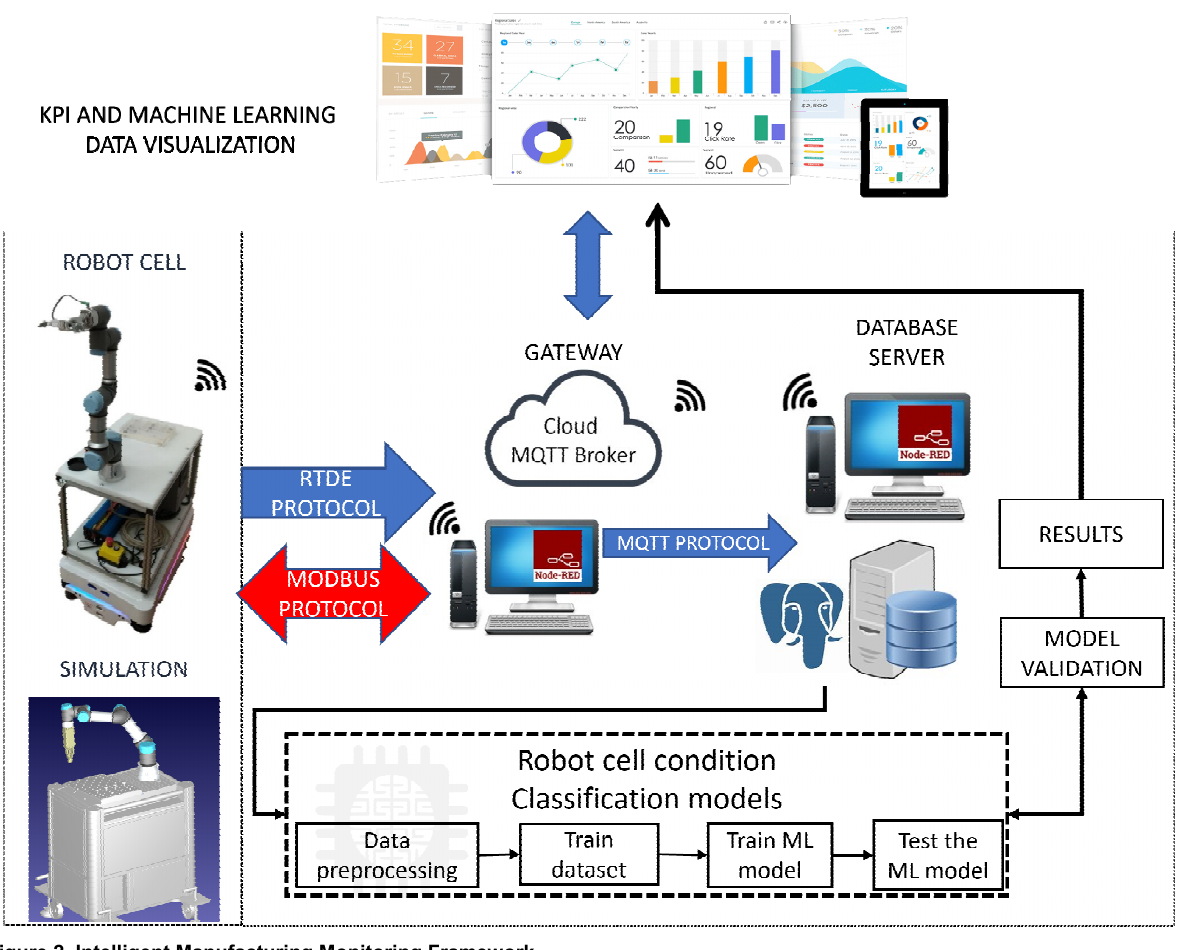
Figure 2. Intelligent Manufacturing Monitoring Framework Table 2. Evaluation metrics and descriptions of the classification models